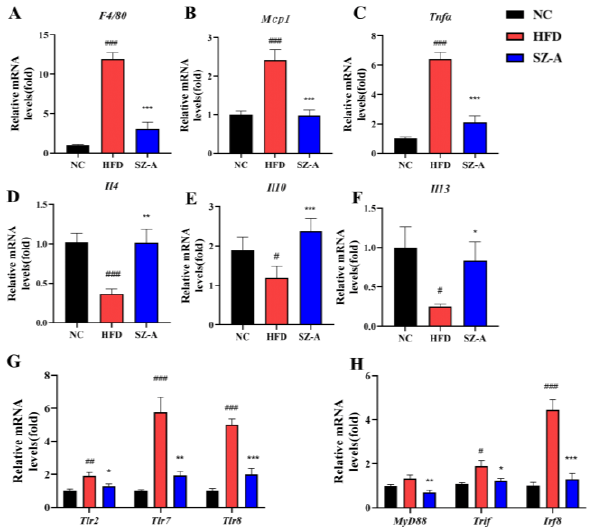
Figure 5. ( A – C ) Relative mRNA expression levels of the pro-inflammatory-related factors, including F4/80 , Mcp1 , and Tnf α , in the three groups. ( D – F ) Relative mRNA expression levels of the anti-inflammatory-related factors, including Il4 , Il10 , and Il13 , in the three groups. ( G , H ) Relative mRNA expression levels of Tlrs and downstream genes, including Tlr2 , Tlr7 , Tlr8 , MyD88 , Trif , and Irf8 . ( n = 6/group). Values represent mean ± SEM. (# p < 0.05, ## p < 0.01, ### p < 0.001 HFD vs. NC and * p < 0.05, ** p < 0.01, *** p < 0.001 HFD vs.